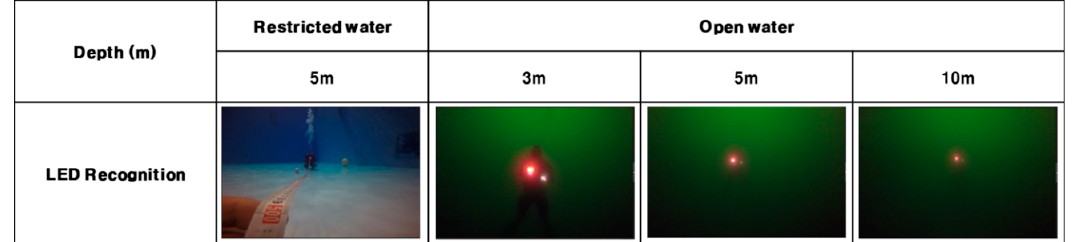
Figure 6. Field tests of LED recognition.